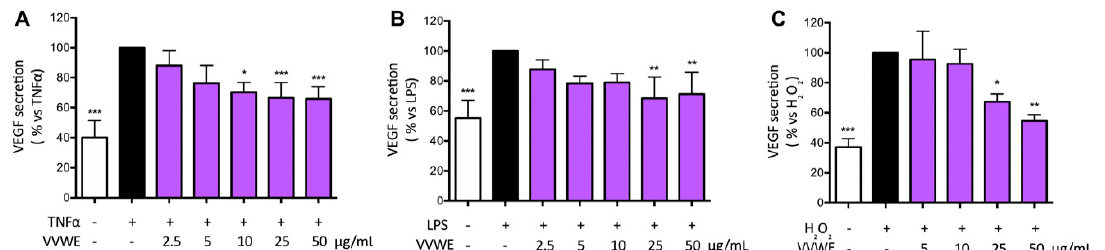
Figure 4. E ff ect of VVWE on vascular endothelial growth factor (VEGF) secretion induced by TNF- α ( A ), LPS ( B ), and H 2 O 2 ( C ). HaCaT cells were treated for 24 h with TNF- α (10 ng / mL), H 2 O 2 (100 µ M) or 30 h with LPS (5 µ g / mL) and VVWE (2.5–50 µ g / mL). Secreted VEGF was evaluated by the ELISA assay. The graphs show the means ± SD of at least three experiments performed in triplicate. Statistical analysis: one-way ANOVA, followed by Bonferroni’s post hoc test. * p < 0.05, ** p < 0.01, *** p < 0.001 vs. TNF- α alone. Here, 20 µ M EGCG were used as the reference inhibitor of TNF- α , LPS, or H 2 O 2 -induced VEGF secretion (78.7%, 100%, and 100% inhibition, respectively).